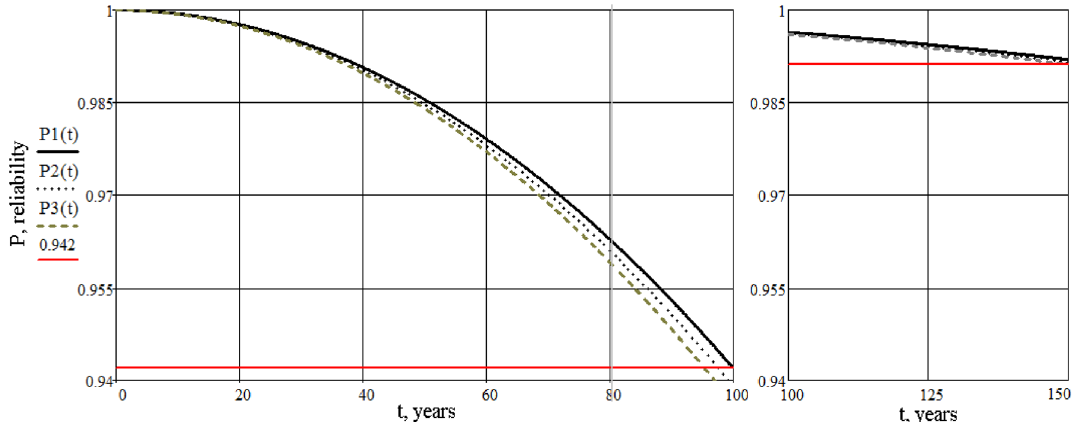
Figure 9. Combined graphs of reliability dependence of the “building-base system”, before and after